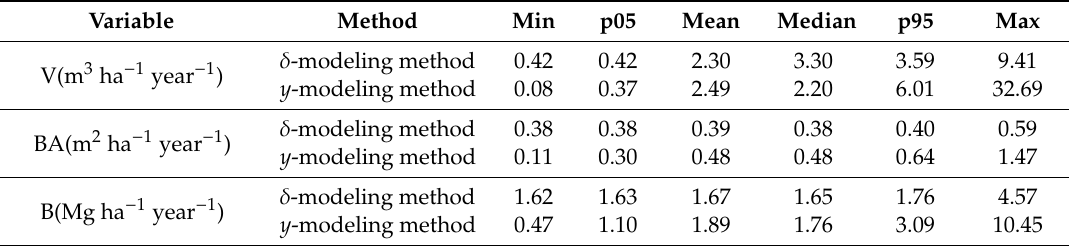
Table 5. Minimum (Min), 5th percentile (p05), mean, median, 95th percentile (p95) and maximum (Max) of RMSE δ (27) and RMSE y (28) for the pixels of the study